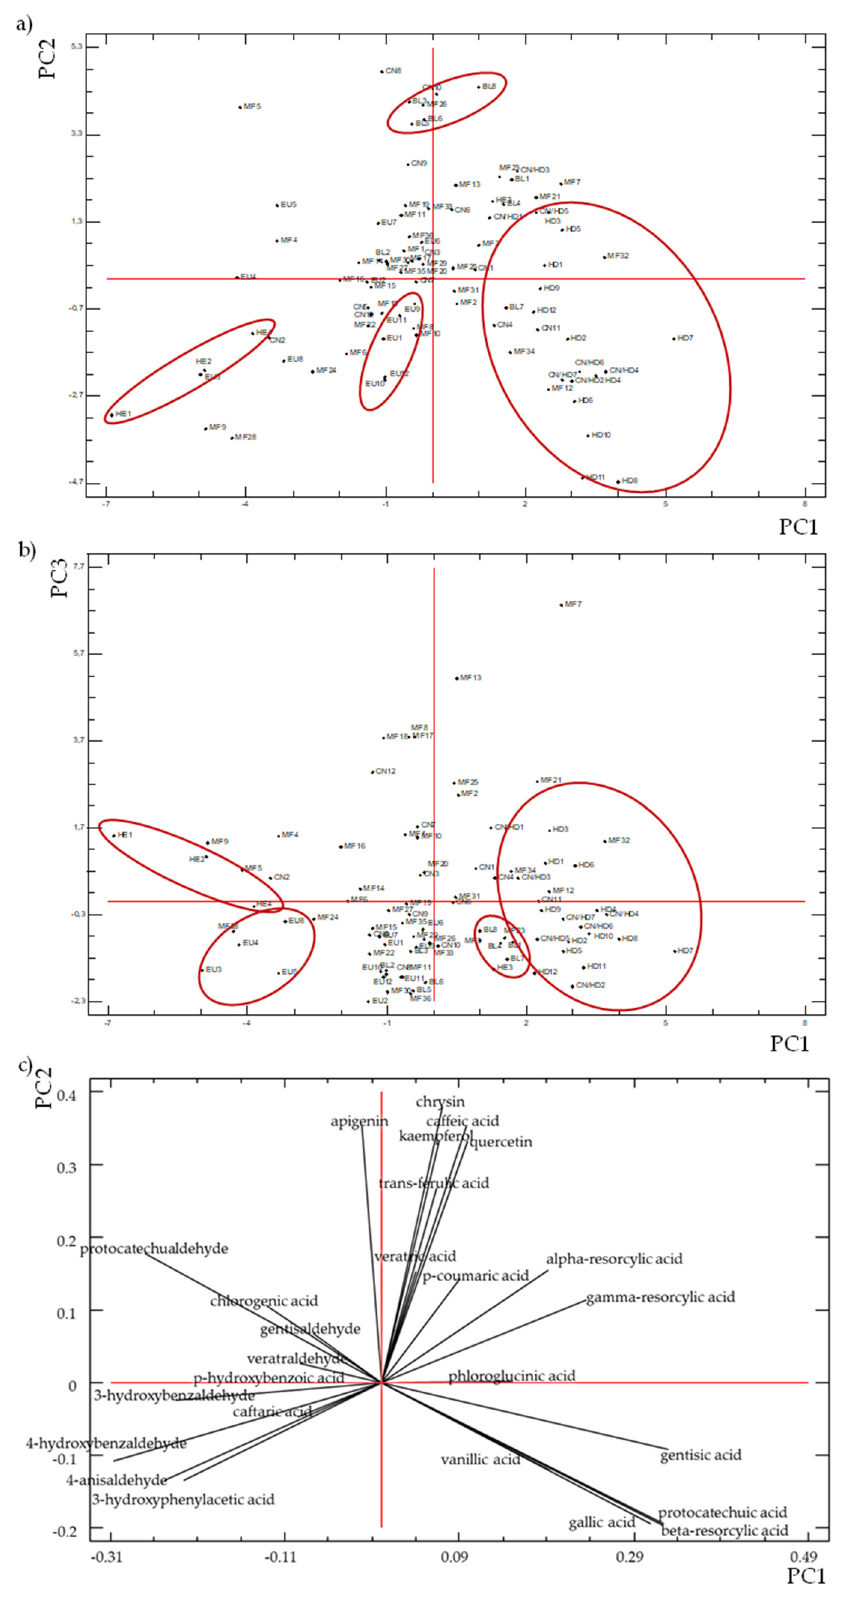
Figure 7. PCA analysis. Scatter plot of ( a ) PC1 and PC2; ( b ) PC1 and PC3; ( c ) plot of component weights for PC1 and PC2 of the 91 analyzed samples. HE: heather, HD: honeydew, CN: chestnut, CN/HD: chestnut/honeydew, EU: eucalyptus, MF: multi-floral, BL: blackberry.